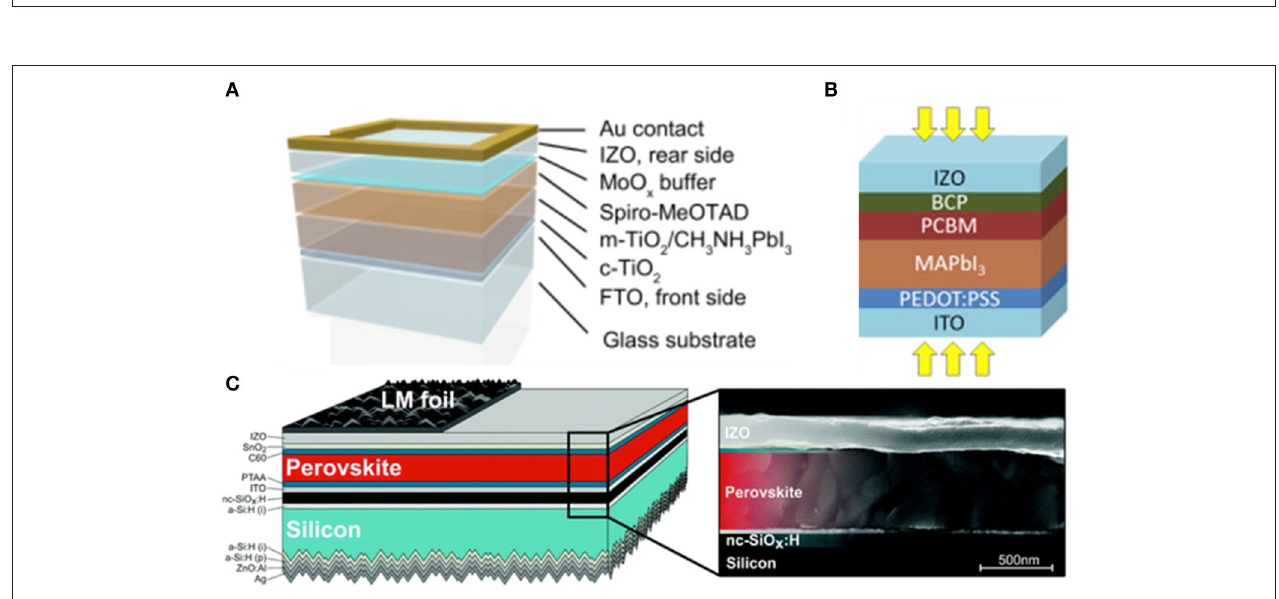
FIGURE 2 | (A) Schematic illustration of a typical PVSK solar cell structure with a transparent rear electrode and Au contact (reproduced from ref. 23, copyright 2015, Elsevier). (B) Structure of semitransparent inverted PVSK solar cells (reproduced from ref. 24, copyright 2015, Elsevier). (C) Tandem solar cell device schematics of the experimentally realized architecture and SEM cross section image of the top cell with the layers as indicated (reproduced from ref. 25, copyright 2018, Royal Society of Chemistry).